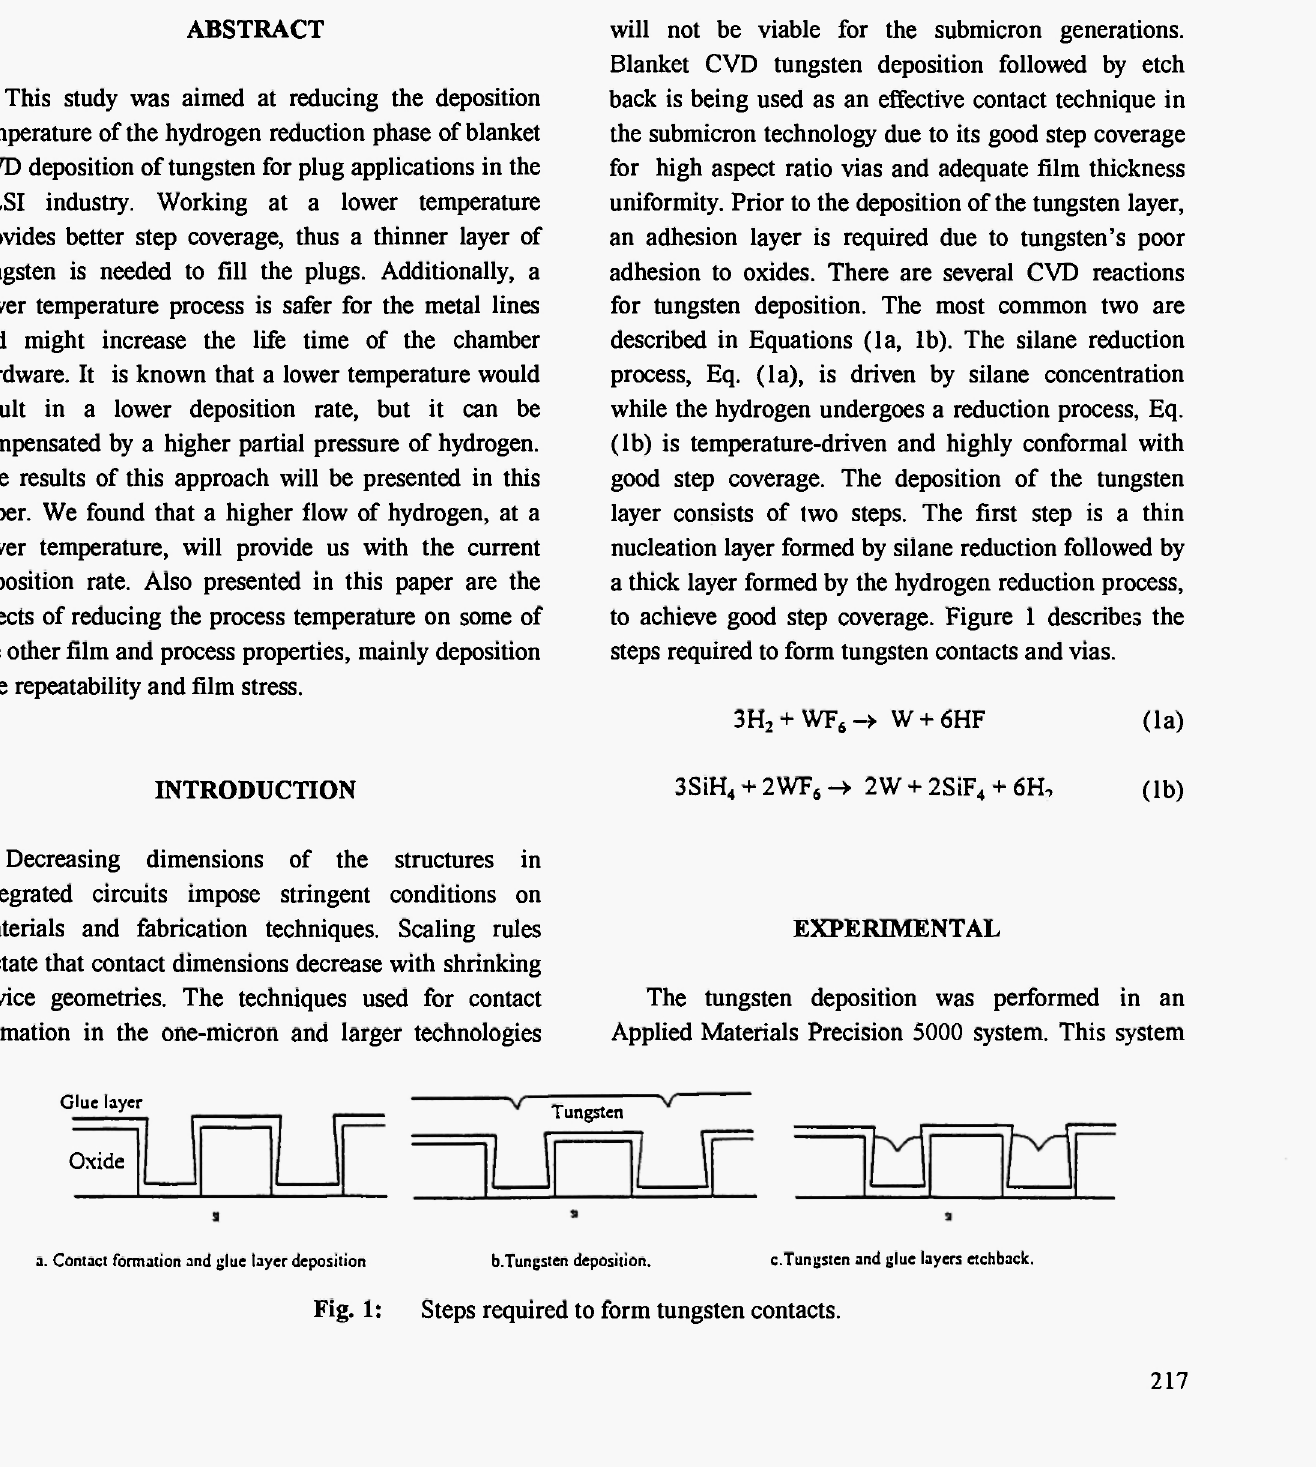
b.Tungsten deposition. c.Tungsten and glue layers etchback. Fig. 1: Steps required to form tungsten